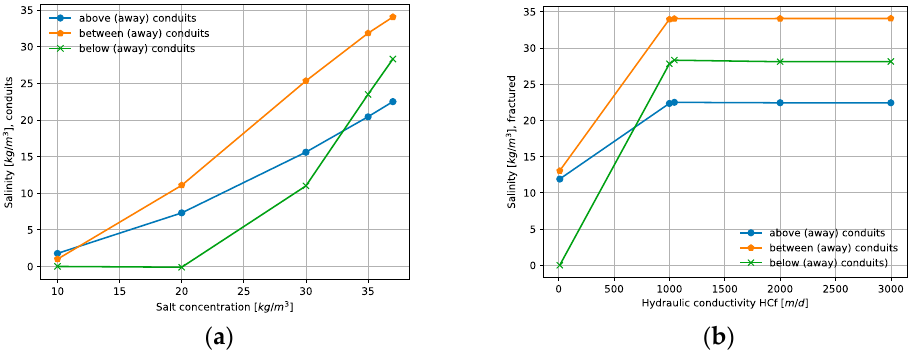
Figure 10. The nonlinear relationship between: ( a ) salinity and ( b ) head simulations with respect to the parameters SC (Salt Concentration) for both conduits.